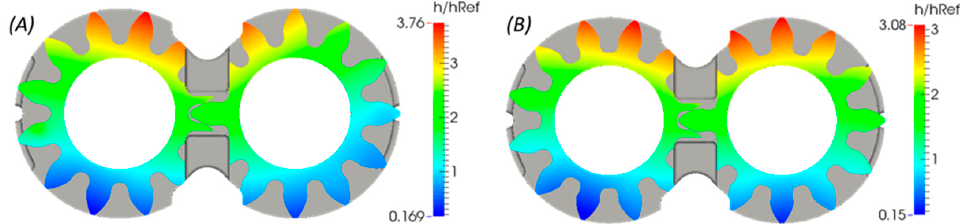
Figure 18. Film thickness distribution in the lateral gap at 1500 rpm and p / p ref = 0.8 as predicted by ( A ) Full Film model; ( B ) Mixed Film model.